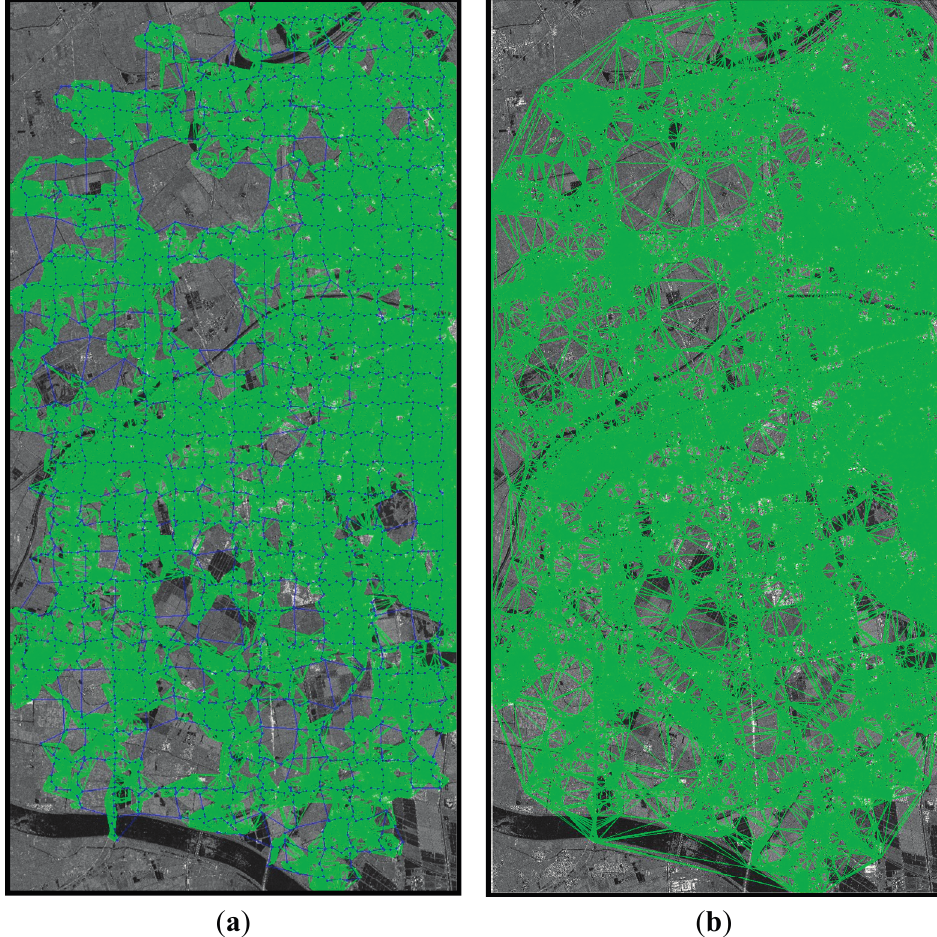
Figure 6. The two types of PS networking for the study area: The left panel ( a ) shows the global control network (GCN) plus localized triangular irregular networks (LTINs) in the 15 × 30 grids of the study area, including 2832 arcs in the GCN and 2998810 arcs in the LTINs. The right panel ( b ) shows the global triangular irregular network (TIN) of the study area, including 3011804